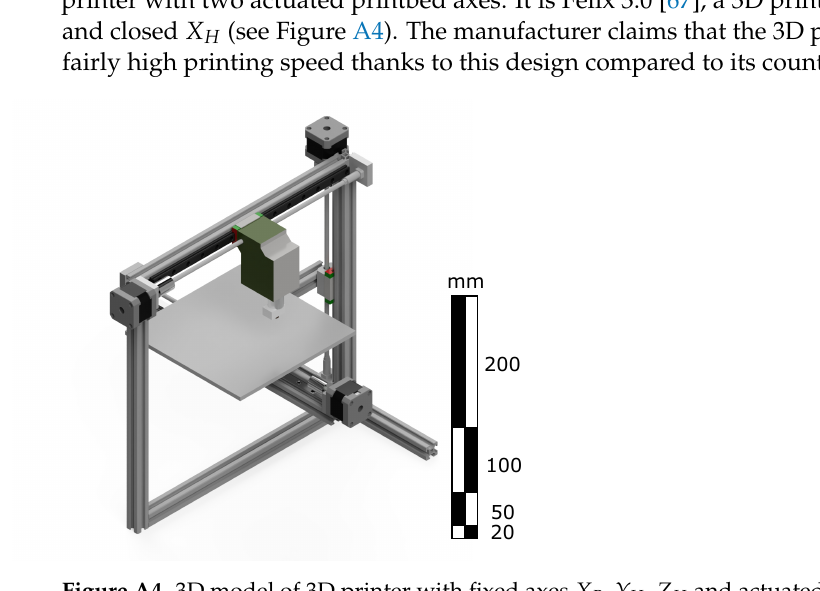
Figure A4. 3D model of 3D printer with fixed axes X B , Y H , Z H and actuated axes X H , Y B , Z B with closed axis X H , and open Y B , Z B